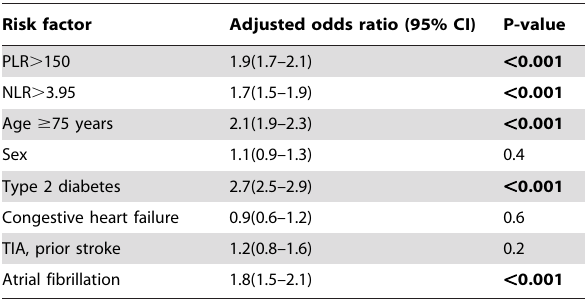
Table 3. Adjusted risk factors for CLI in PAOD